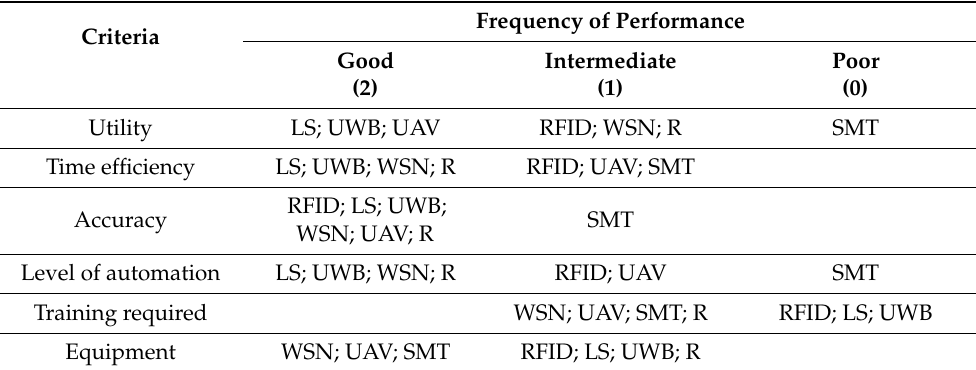
Table 13. Frequencies obtained according to the criteria for